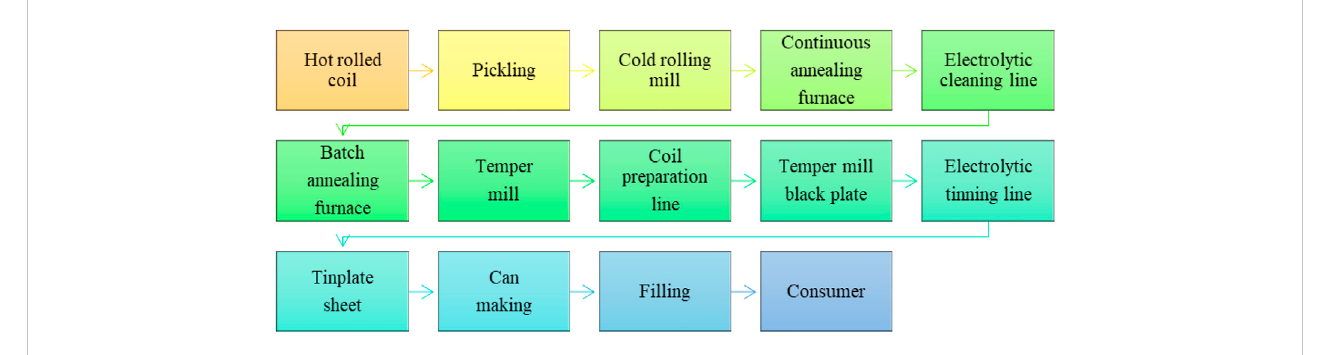
FIGURE 2 Schematic diagram of the manufacturing fl ow process of tinplating process.